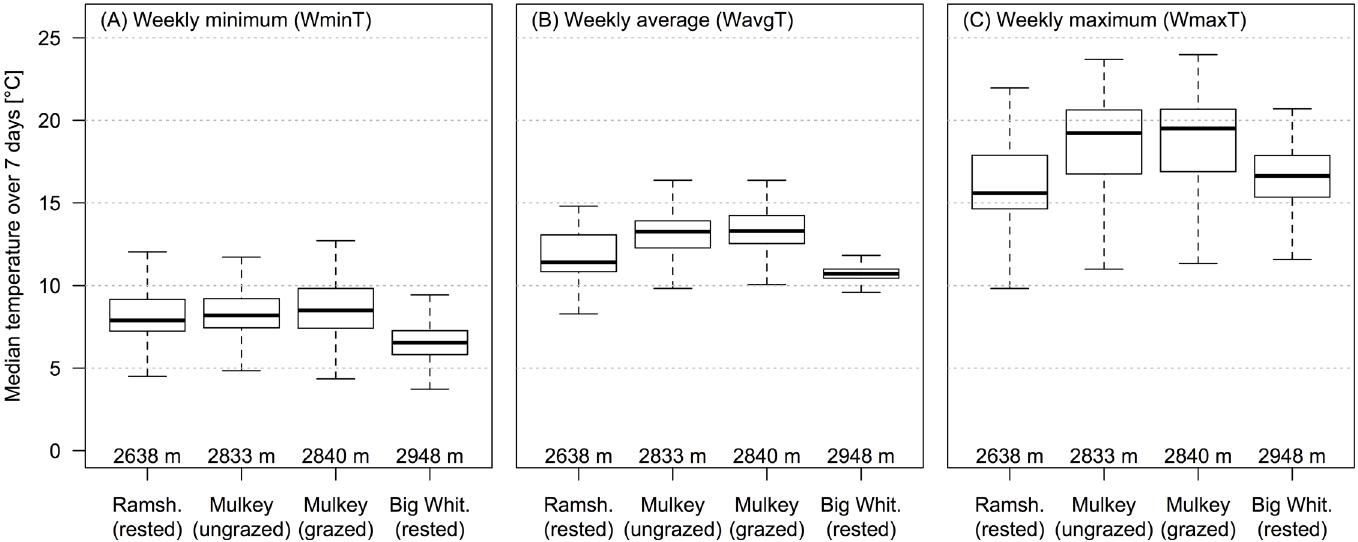
Fig 5. Temperature summaries. Temperature was recorded every 20 – 30 minutes at each probe. To limit the amount of data from each probe (and to remove temporal autocorrelation), we calculated three metrics that resulted in only one value/probe/day for analyses (See S1 Fig): daily minimum (DminT), daily average (DavgT), and daily maximum (DmaxT). To remove exceptional or erroneous data, we then computed the median value over seven day windows for each of these three metrics. Each boxplot represents the overall variation for the median daily value over seven day moving windows (WminT, WavgT, and WmaxT) in the three different meadows, with the two different areas (grazed/ungrazed) in Mulkey. The plots are arranged in order from (left to right) the lowest elevation meadow (Ramshaw) to the highest elevation meadow (Big